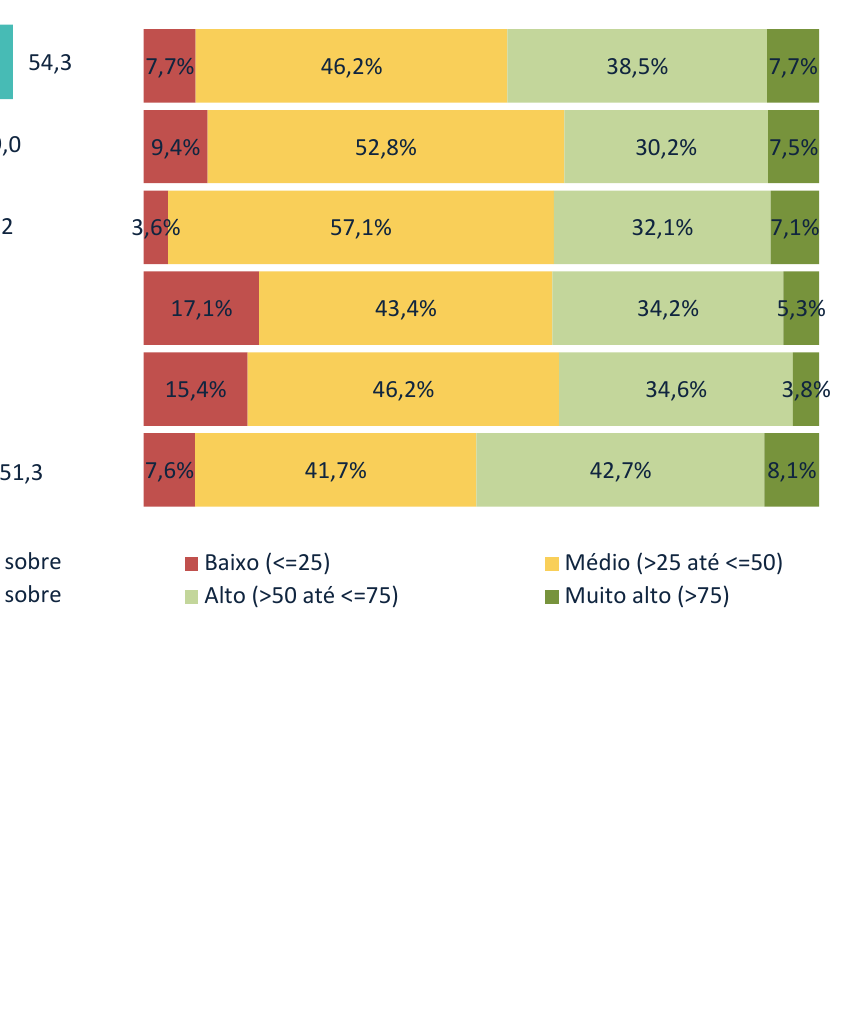
Nota: Os resultados apresentados para a Agricultura não são estatisticamente significativos uma vez que a base amostral é inferior a